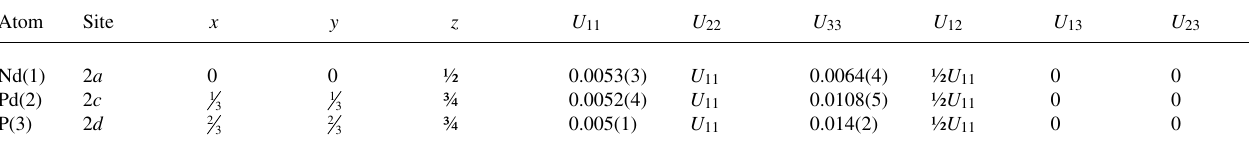
Table 2. Atomic coordinates and displacement parameters (in Å 2 )